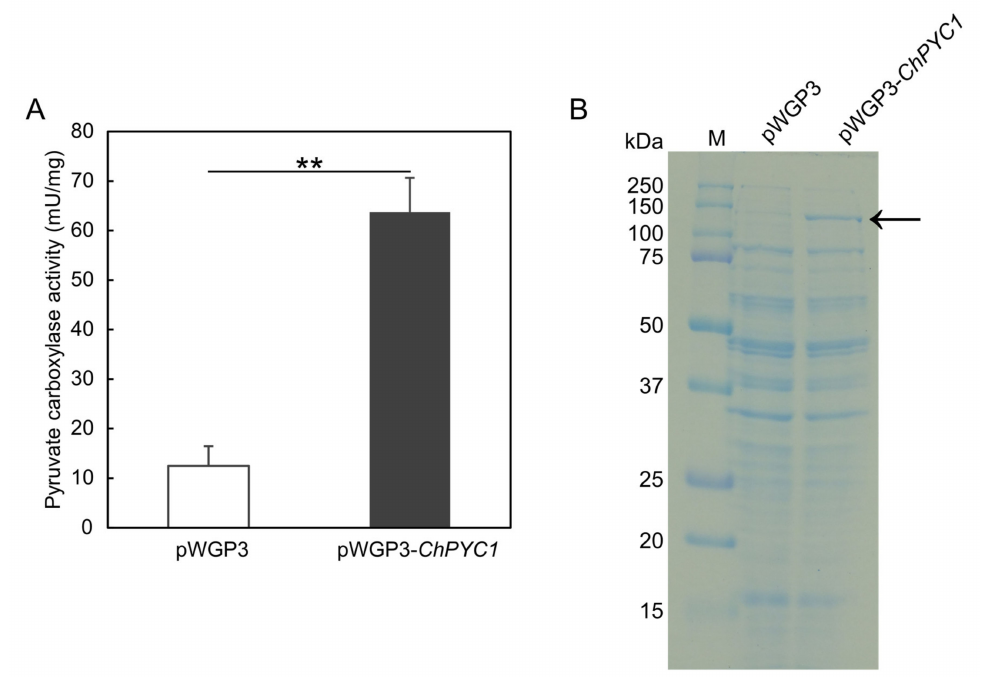
Figure 2. The expression of ChPYC1 in S. cerevisiae . ( A ) Pyruvate carboxylase activity of crude extracts from S. cerevisiae cells with (pWGP3- ChPYC1 ) and without ChPYC1 gene (pWGP3). The activity was assayed spectrophotometrically by malate dehydrogenase (MDH) coupled assay as reported by Payne and Morris [33]. Statistical differences were ascertained by Welch’s t -test, ** p < 5 × 10 − 3 . The values are the means of three independent experiments, and the error bars represent the standard deviations. ( B ) SDS-PAGE analysis of the crude extracts from S. cerevisiae cells with (pWGP3- ChPYC1 ) and without ChPYC1 gene (pWGP3). The 10 µ g proteins were separated by 12% SDS-PAGE and stained with Coomassie Brilliant Blue. The arrow indicates the protein band corresponding to ChPyc1 (molecular mass: approximately 133